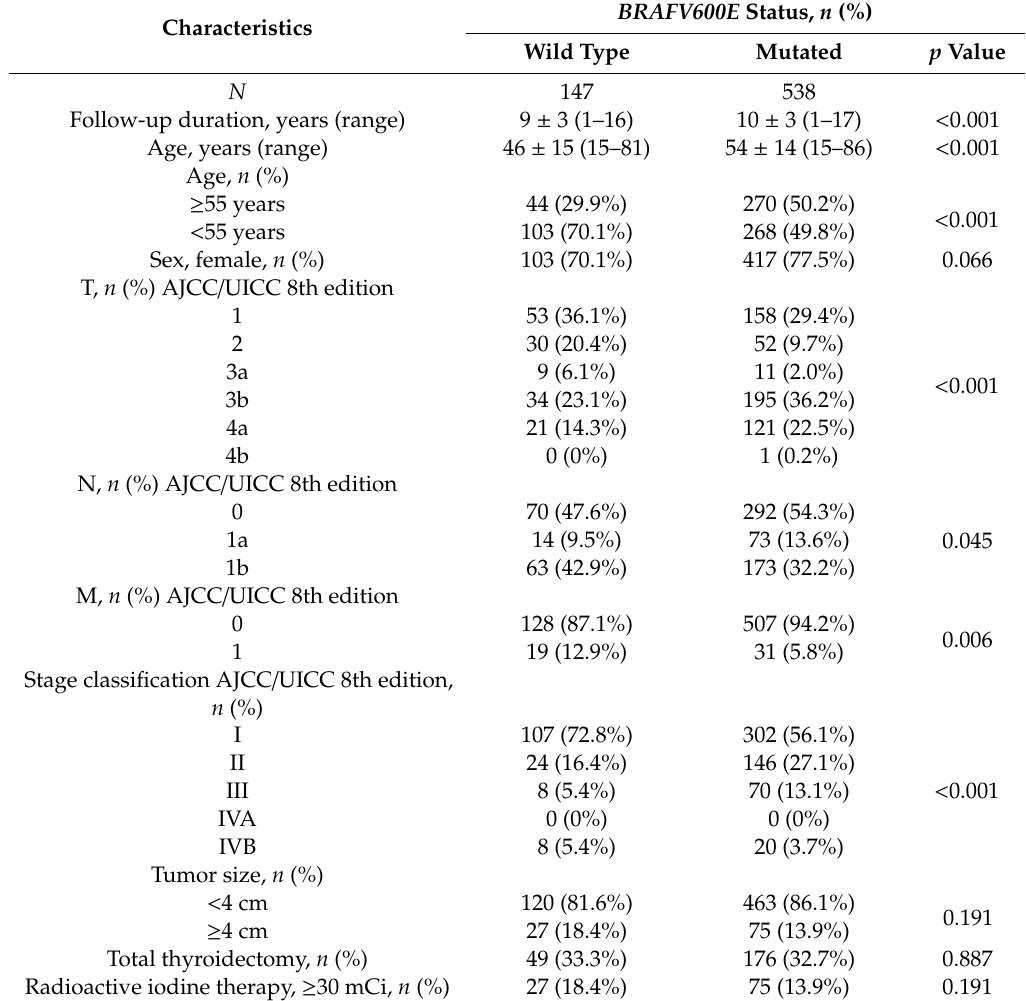
Table 3. Characteristics of patients with and without BRAF V600E mutation.